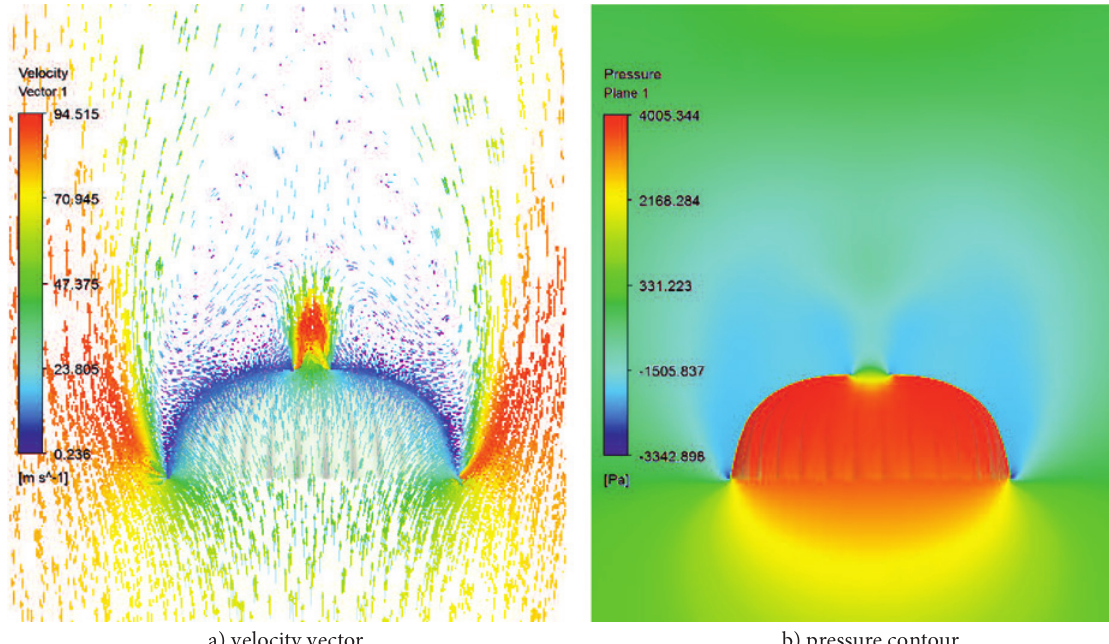
Fig. 13. Flo w fie ld results based on CFD